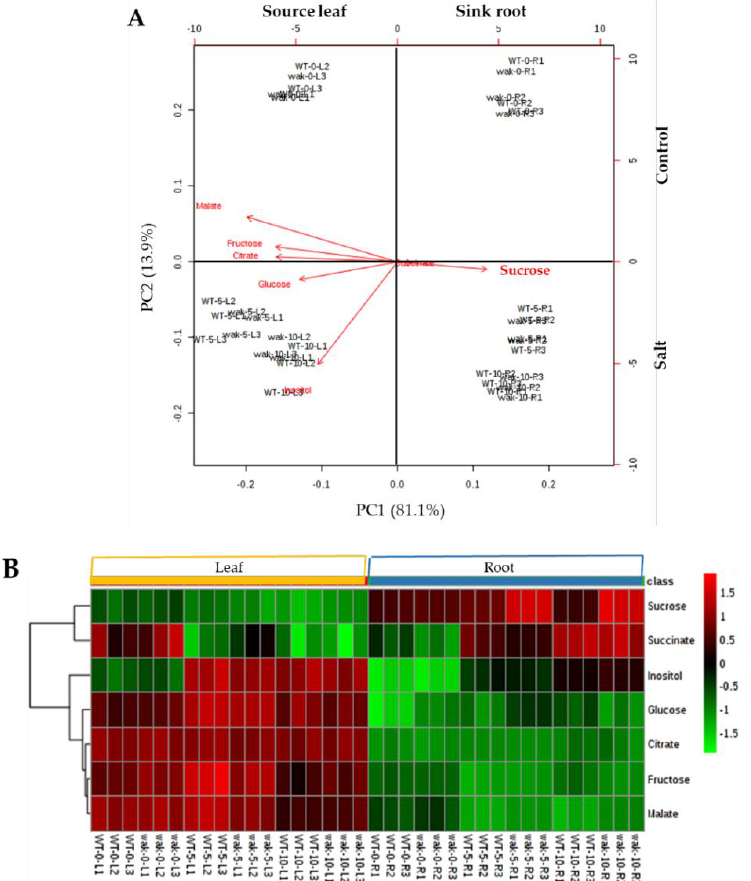
Figure 6. Changes in the metabolite profiles induced by the disruption of SlWAK1 in source leaf and sink root. Plants of WT and Slwak1 were analyzed after 0, 5 and 10 days of salt treatment (200 mM NaCl). ( A ) Non-supervised principal component analysis (PCA) and ( B ) heatmap analysis representing the major sources of variability. Color scale represents the variation in the relative concentration of compounds, from high (red) to low (green) contents.